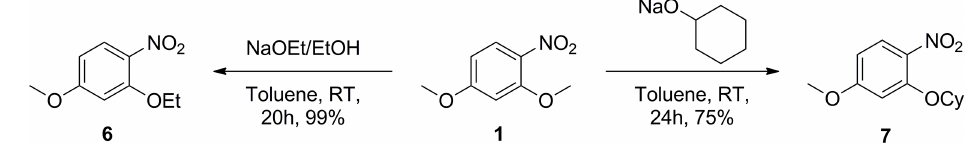
Fig 6. S N Ar reactions of sodium ethoxide and sodium cyclohexanolate.